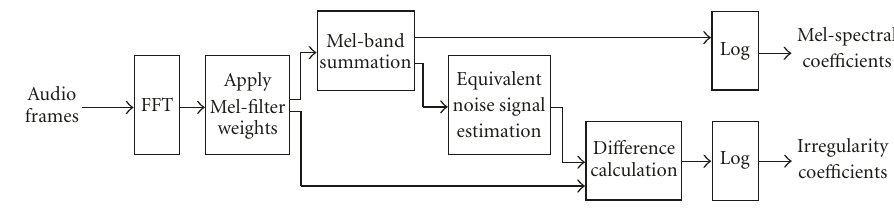
Figure 2: Spectral irregularity